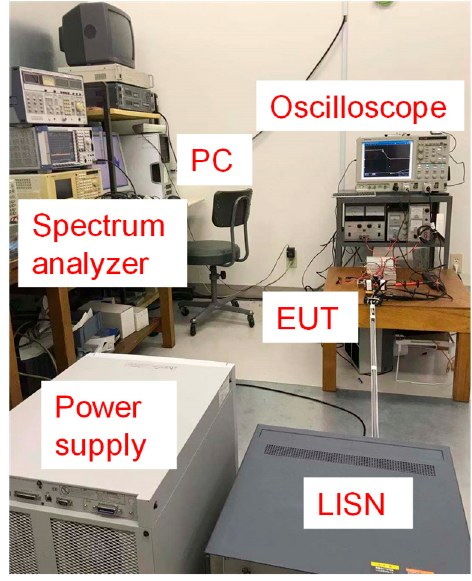
Figure 5. The experimental setup of conducted noise measurement.